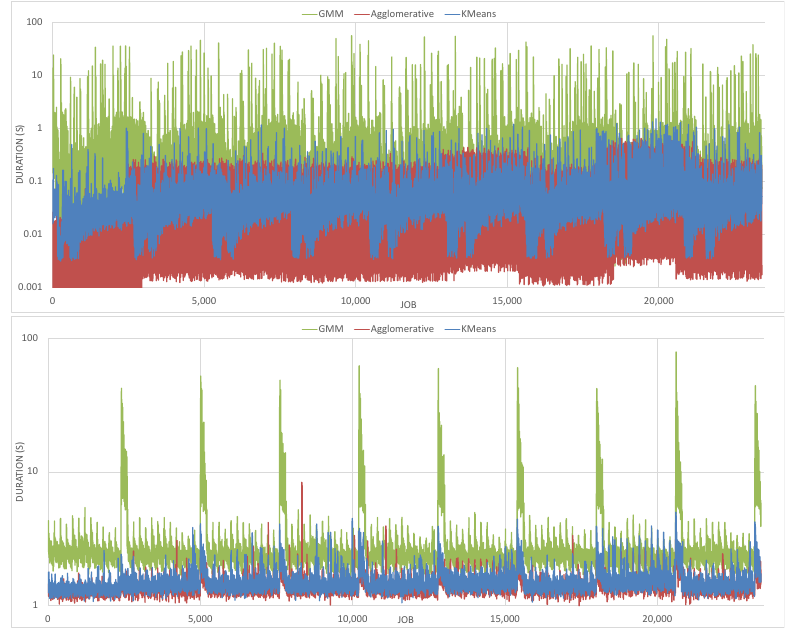
Figure 5. Process benchmark of the CMU Kitchen experiments (y-axis log-scale). Durations (in s) of only the clustering process (top), as well as the whole experiment run (bottom), including preprocessing and feature extraction, are shown. Benchmarked algorithms are k-means (blue), agglomerative clustering (red) and GMM